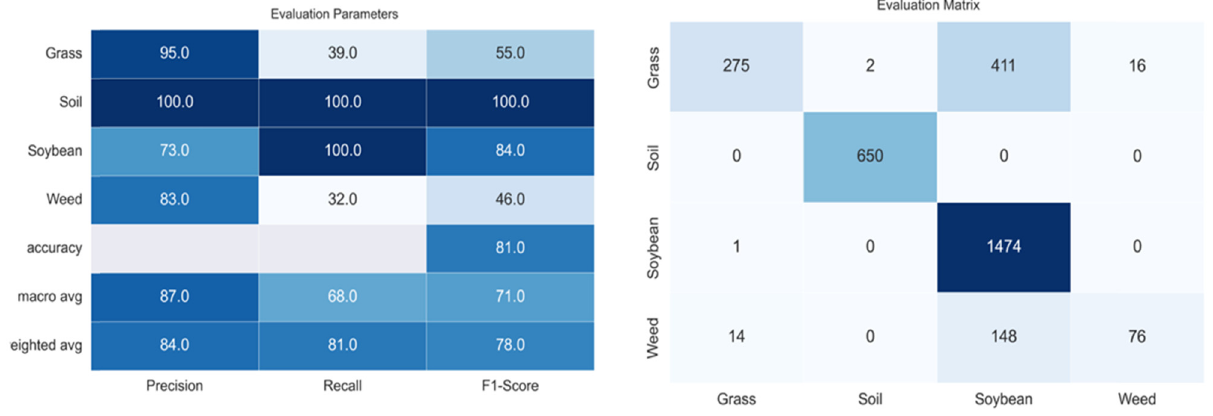
Figure 8: Testing on haze dataset.